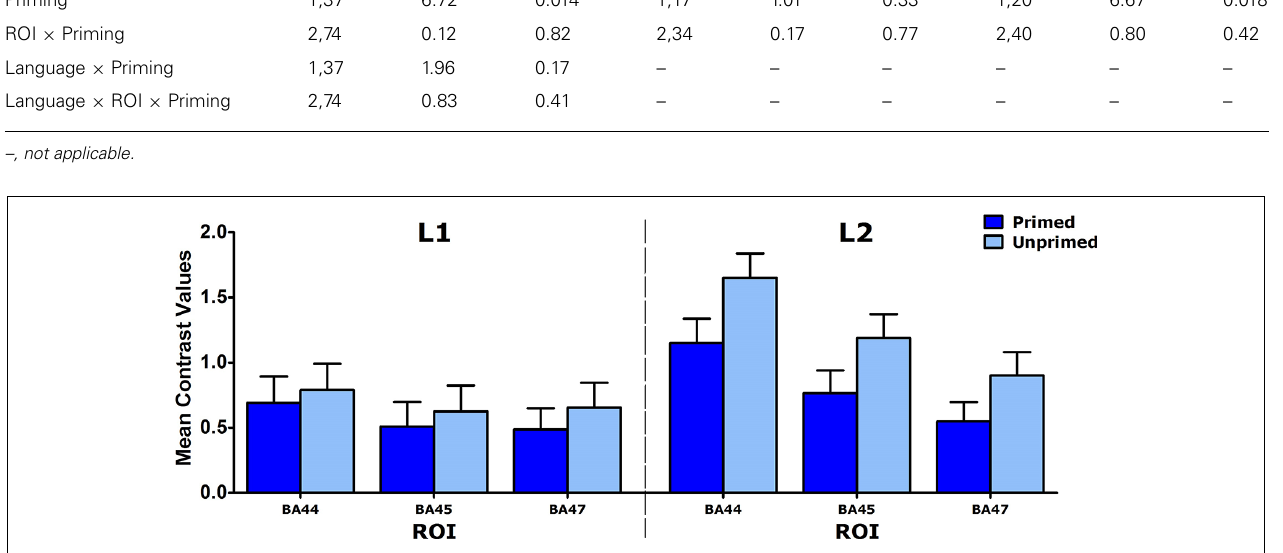
FIGURE 1 | Mean contrast values for three LIFG ROIs (BA44, BA45, and BA47) for L1 and L2 speakers. Error bars: + 1 SE.